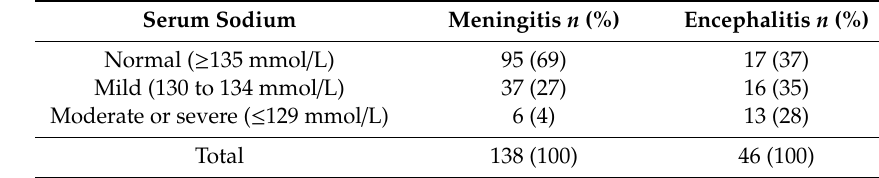
Table 4. Hyponatremia severity by clinical